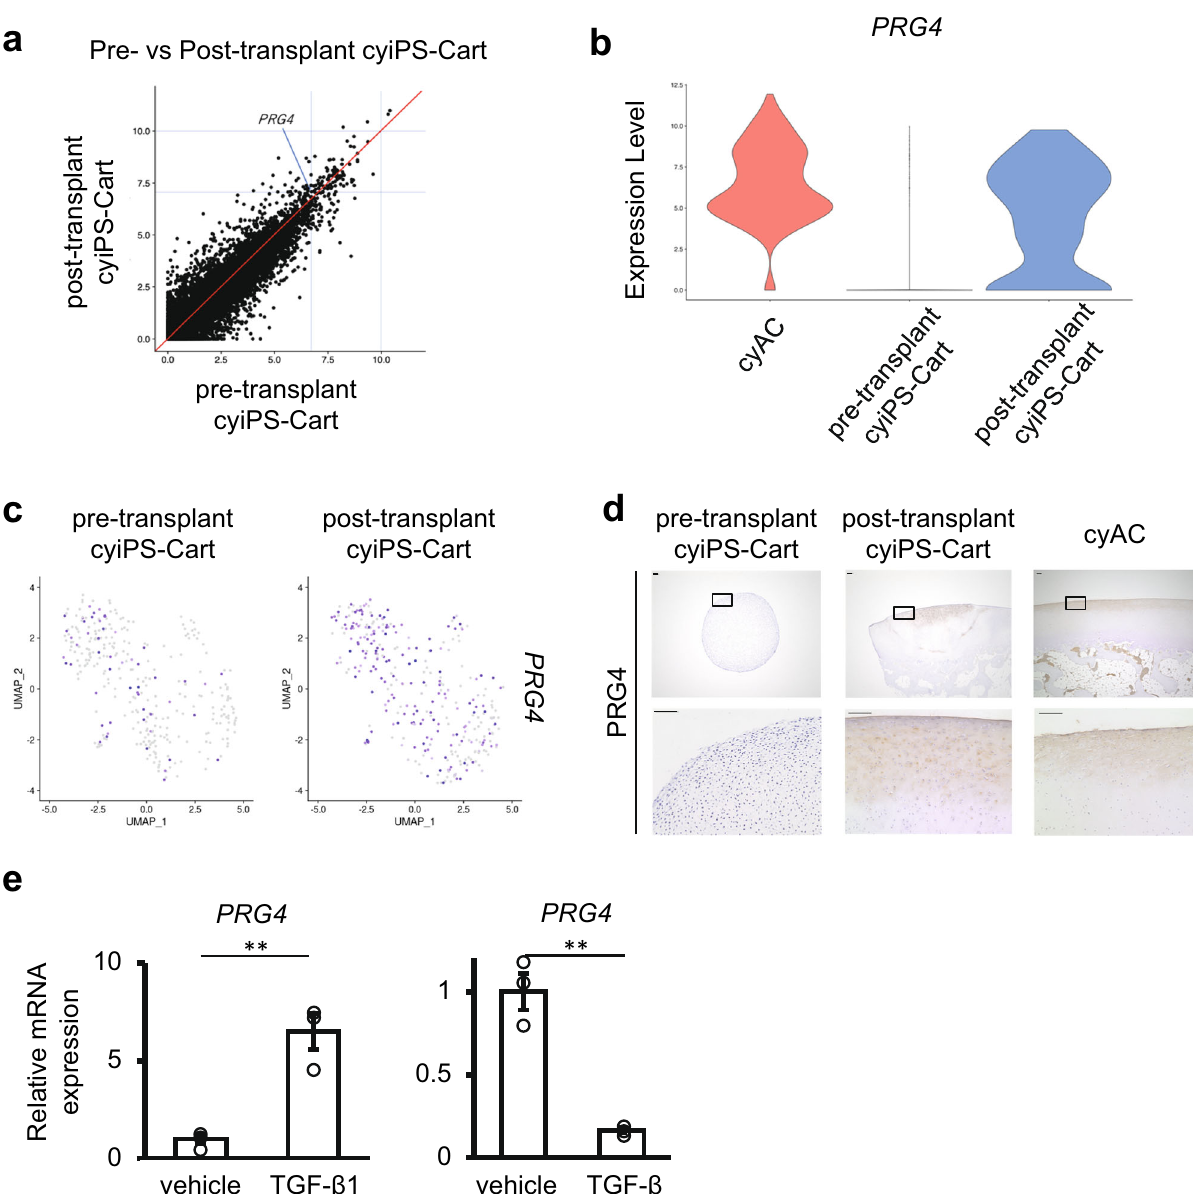
Fig. 7 | Expression of PRG4 in cyAC, pre-transplant cyiPS-Cart, and post- transplantcyiPS-Cart.a Theexpressionlevelofeachgeneinpre-transplantcyiPS- Cartisplottedonthex-axisandtheexpressionlevelinpost-transplantcyiPS-Cartis plotted on the y-axis. b VlnPlot of PRG4 expression for each sample. c PRG4 expressionlevelsindicatedineachcellprojectedontheUMAPplotinFig.6b,using the FeaturePlot function. d Histological sections were immunostained for PRG4 expression. A magni fi cation of the boxed regions in the top row is shown in the